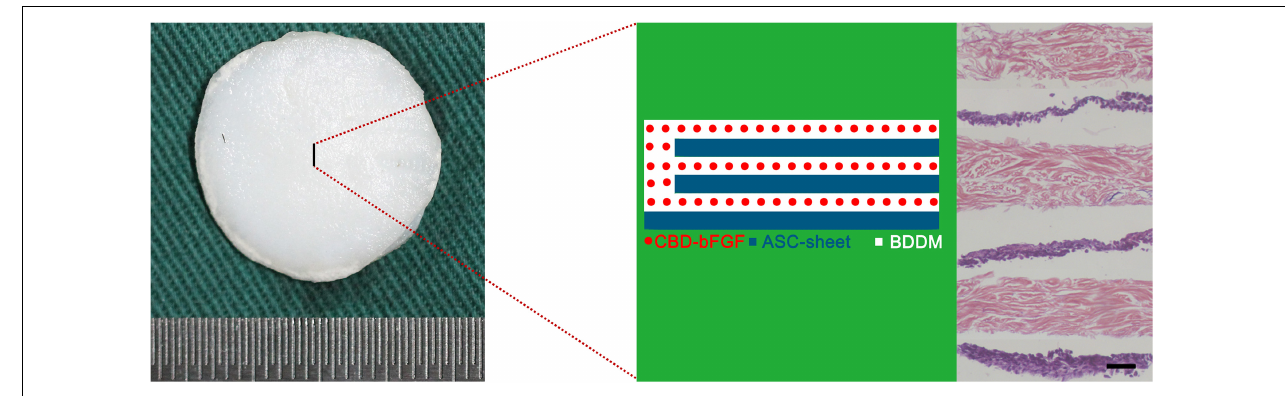
FIGURE 6 | Gross appearance and histological morphology of adipose-derived stromal cells/collagen-binding domain–basic fibroblast growth factor/book-shaped decellularized dermal matrix. Bar = 100 µ